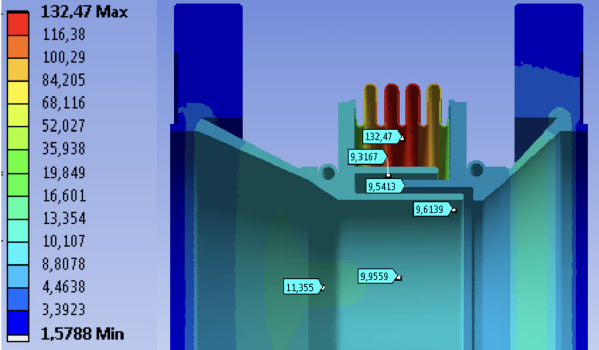
FIG. 6. Temperature distribution in K as simulated with a total thermal load of 31.3 W.